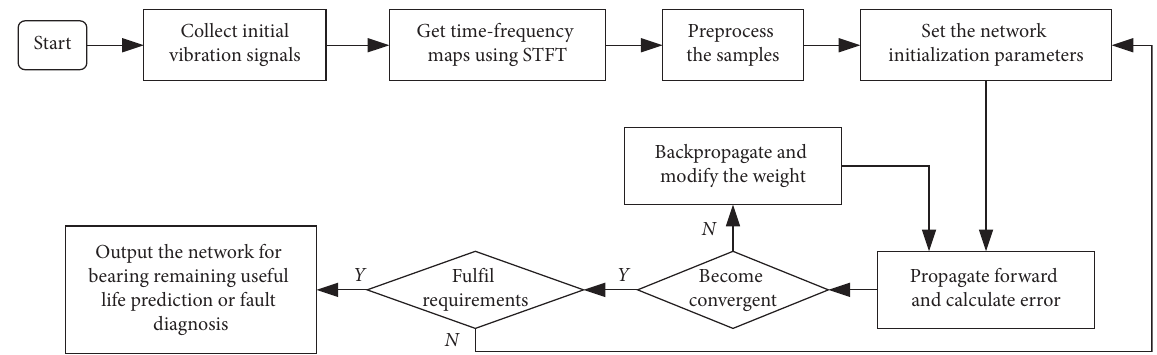
Figure 2: Bearing remaining useful life prediction and fault diagnosis based on STFT and